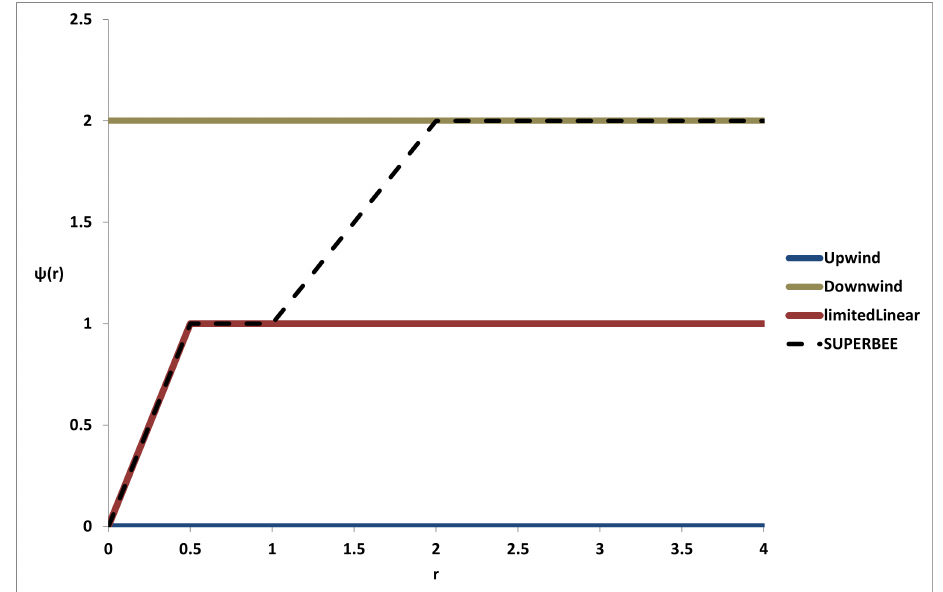
Figure 4. Representation in a Sweby diagram of the “limitedLinear” and “SUPERBEE” limiters.